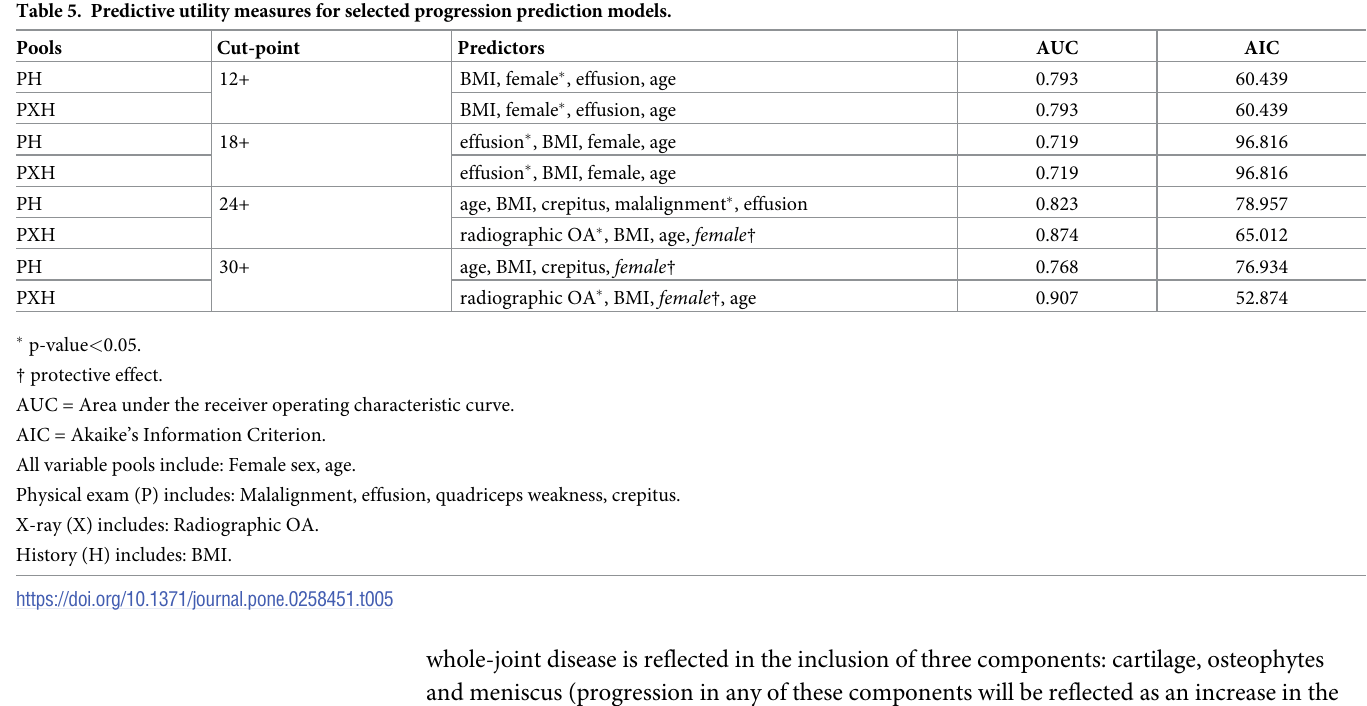
and meniscus (progression in any of these components will be reflected as an increase in the overall score). Furthermore, the irreversibility of knee OA disease as a whole is reflected in the included components; notably omitted are reversible components (e.g., bone marrow lesions and effusion). To clarify its potential use as a research outcome, while MRI is more costly than x-ray and hence may be prohibitive in clinical practice, an MRI-based whole-joint score such